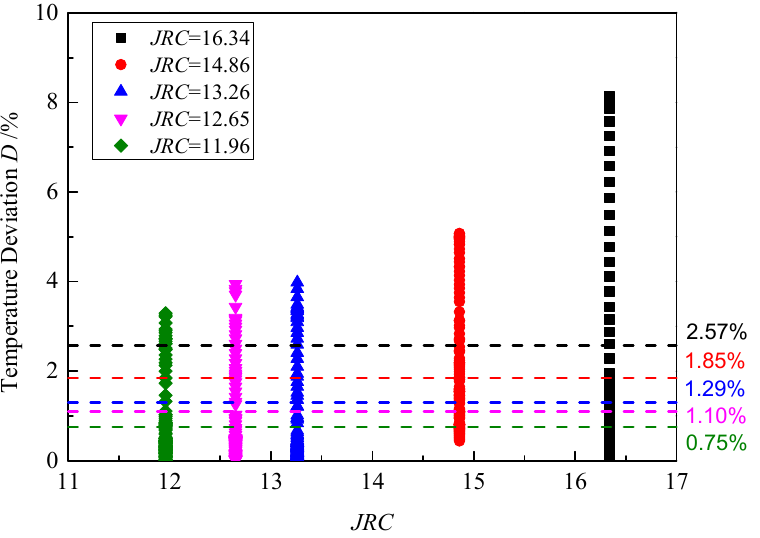
Figure 10. Deviation from heat flow simulations D s for the proposed NPCTF, where the mean deviations of the model with different JRC are 2.57%, 1.85%, 1.29%, 1.10%, and 0.75%, respectively, as represented by dashed lines.